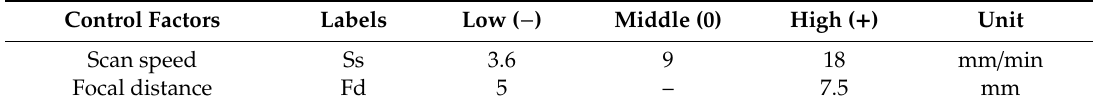
Table 3. Control factors and their levels.